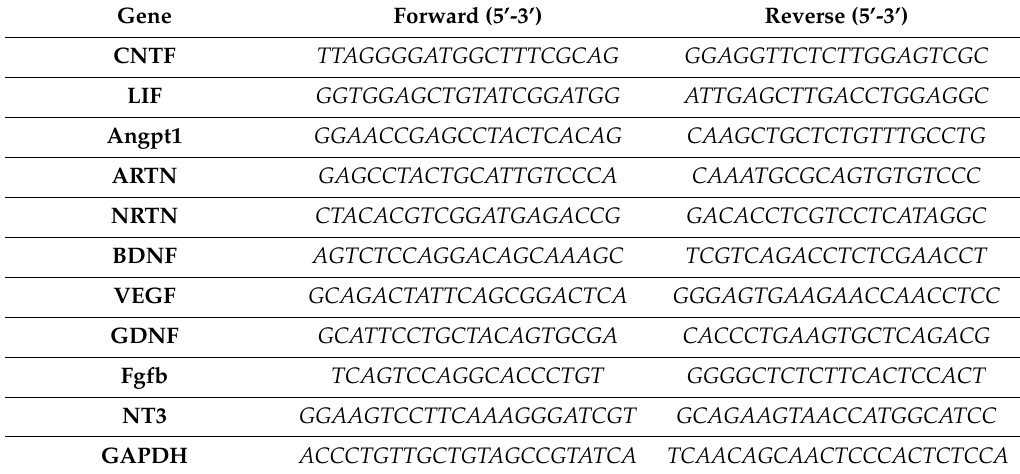
Table 1. Primers used in the present